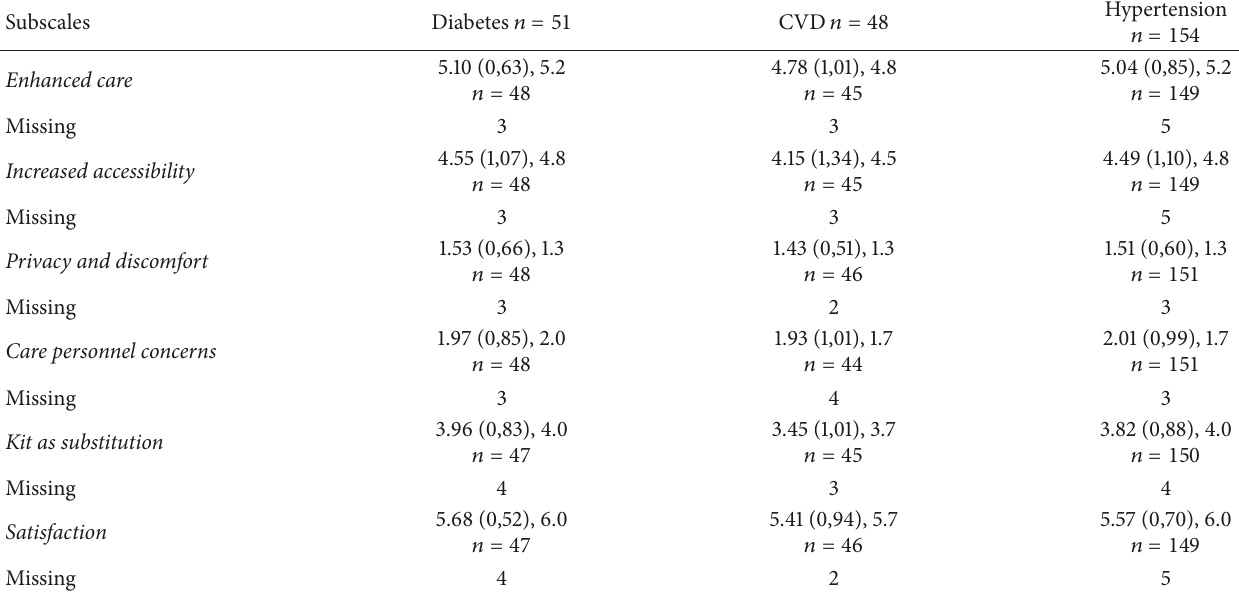
Table 2: Results questionnaire, Service User Technology Acceptability Questionnaire